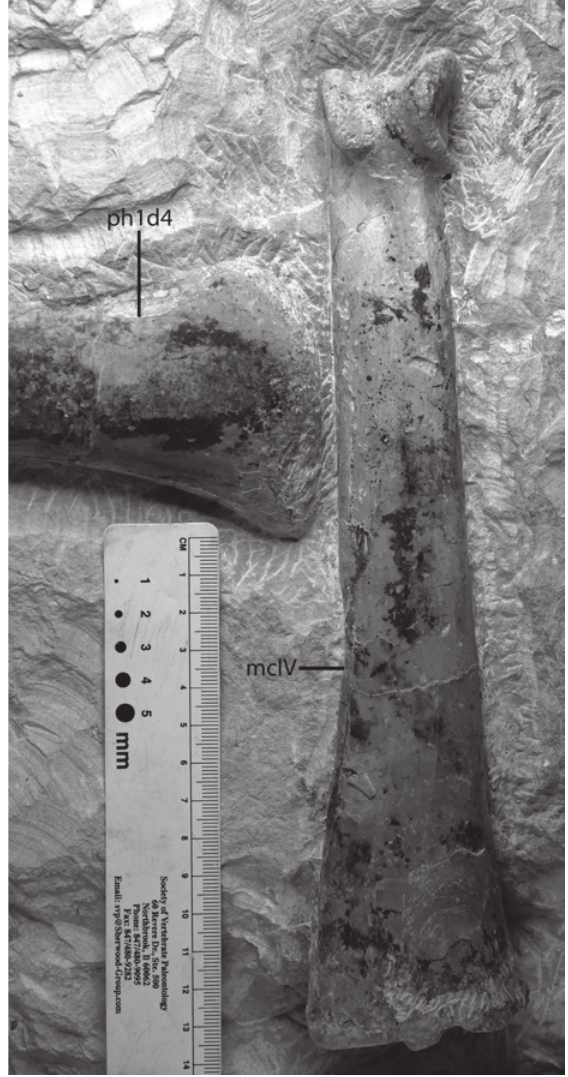
Fig. 10 - Wing elements of MPSC R 1395. See text for abbreviations.